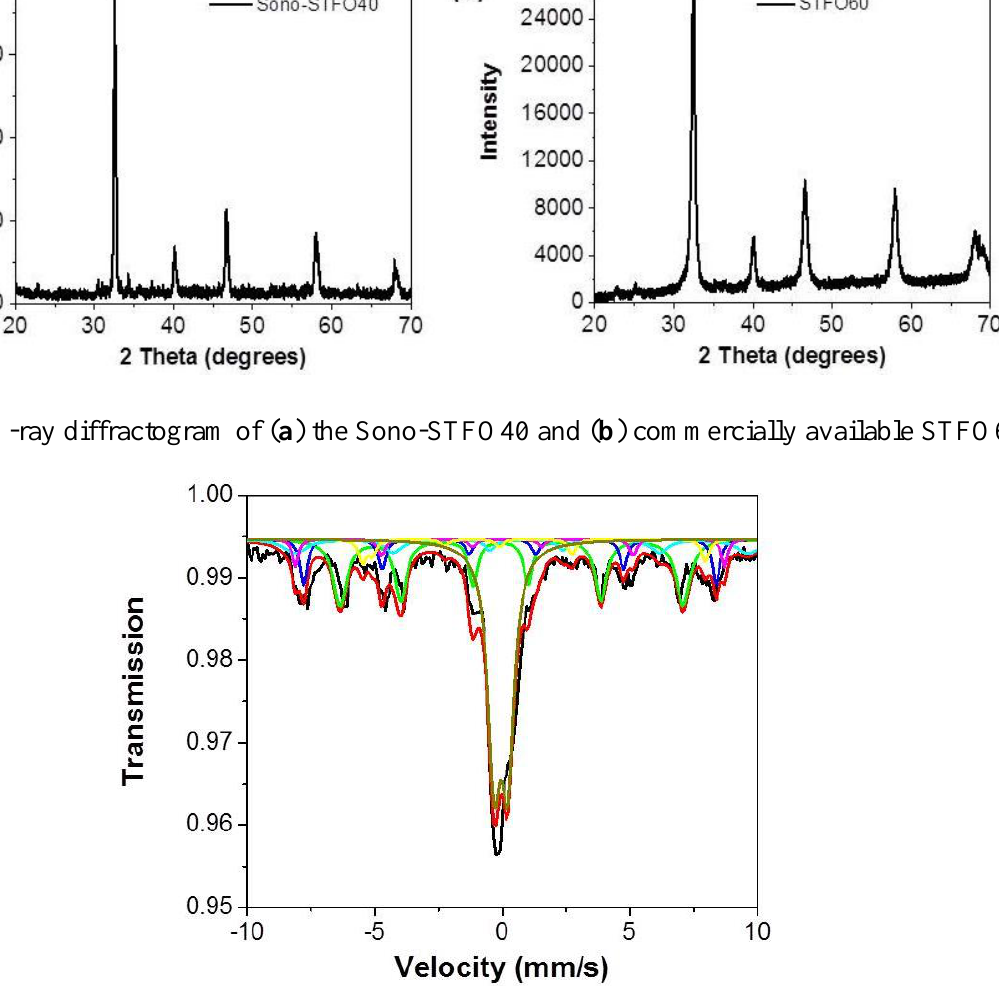
Figure 4. The Mössbauer spectrum of